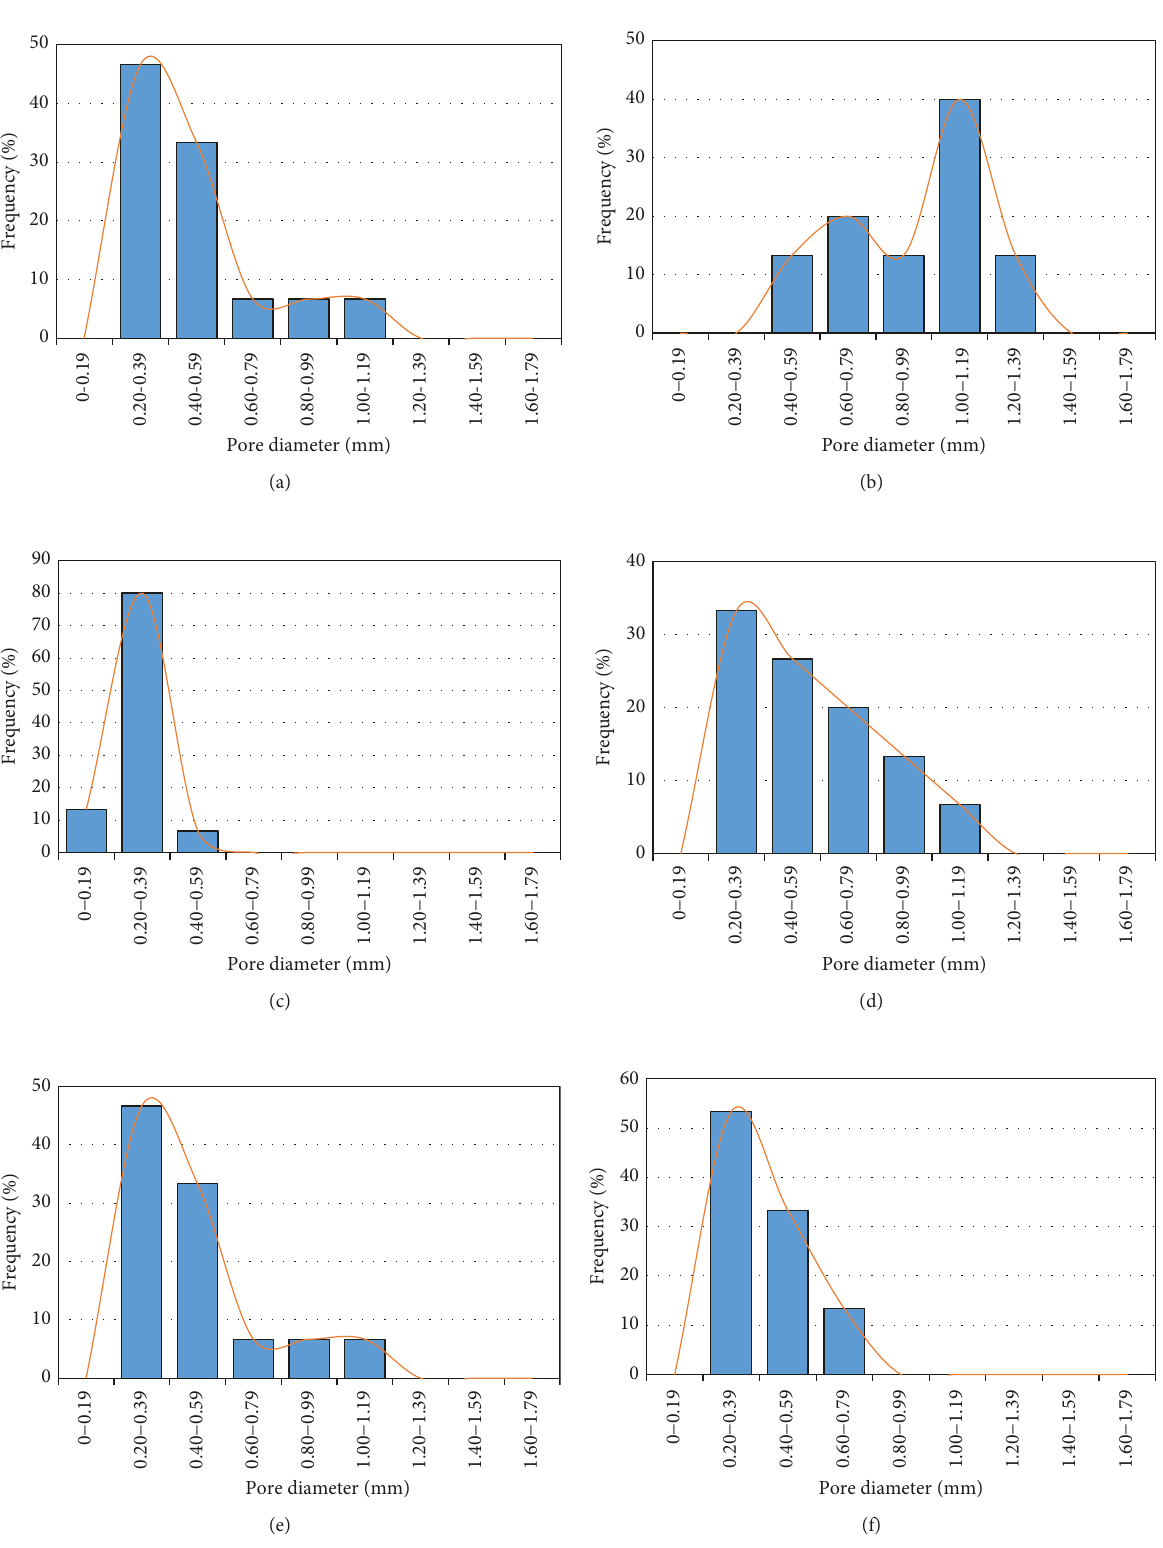
Figure 8: Pore size distribution of Si samples in relation to the R/Al molar ratio (a, b, and c) and the foaming agent content (d, e, and f). (a) exp. 5 (R/Al 0.8, Si 0.085%); (b) exp. 6 (R/Al (cid:31) (cid:31) exp. 5 (R/Al 0.8, Si 0.085% w/w); (f) exp. 13 (R/Al (cid:31) (cid:31)